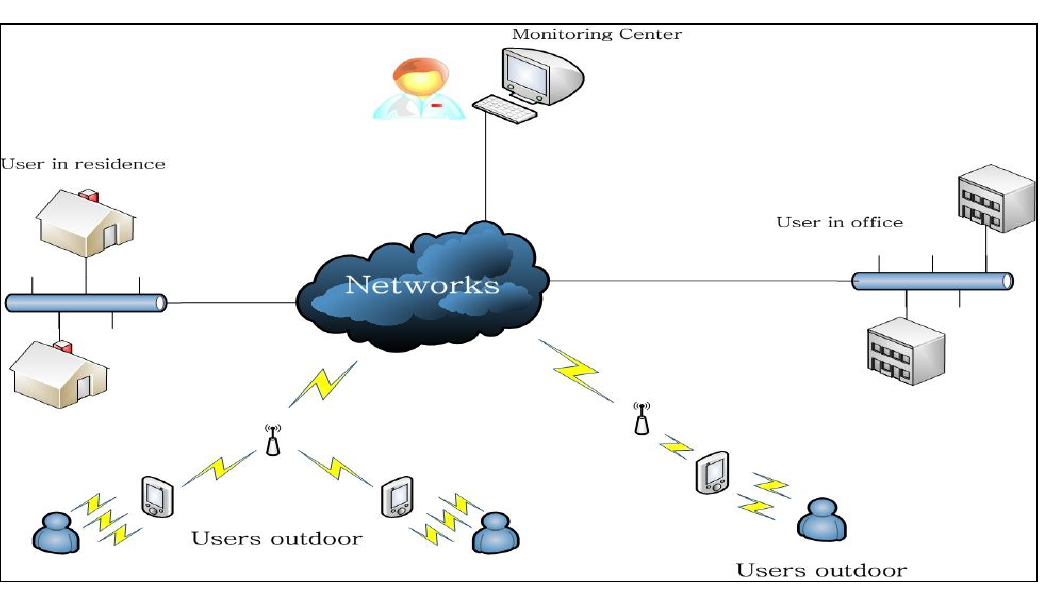
Figure 2. The health monitoring system deployment